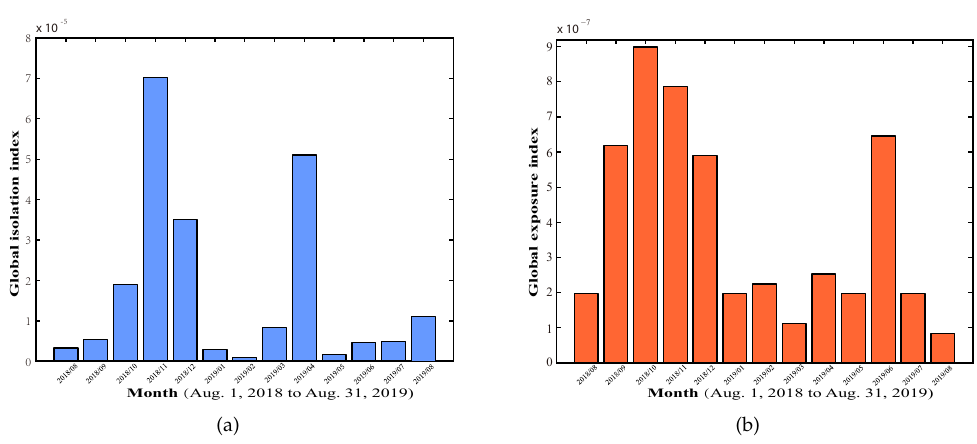
Figure 9. ( a ) Global isolation index of ASF cases from 1 August 2018 to 31 August 2019. ( b ) Global exposure index of ASF cases from 1 August 2018 to 31 August 2019.